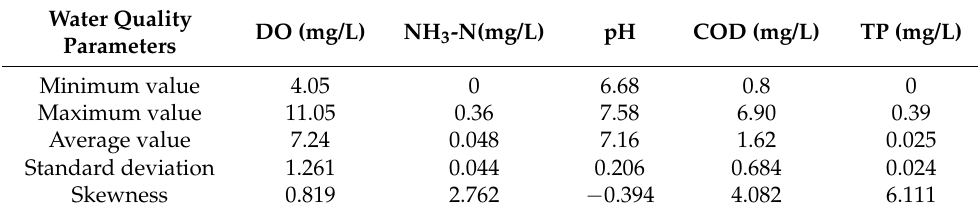
Figure 2. Geographical position of the water quality monitoring station. Table 1. Water quality information statistics. Table 1. Water quality information statistics.